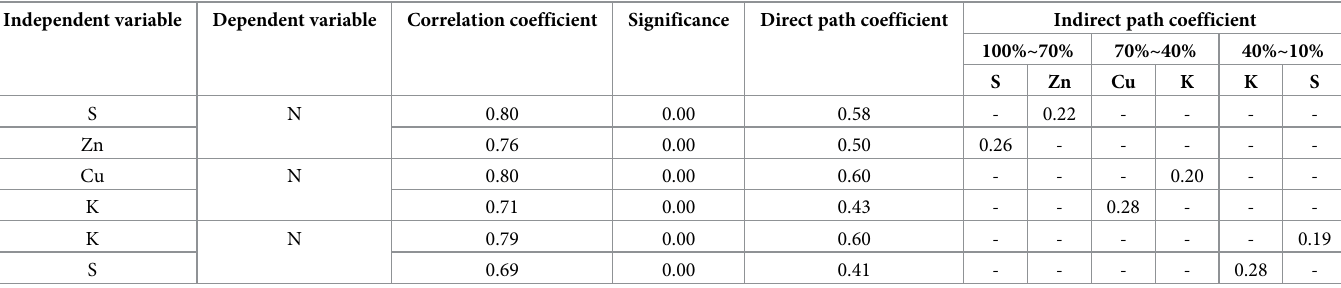
Table 4. Direct and indirect path coefficients between N and S, Zn, Cu, and K in L . chinensis . Independent